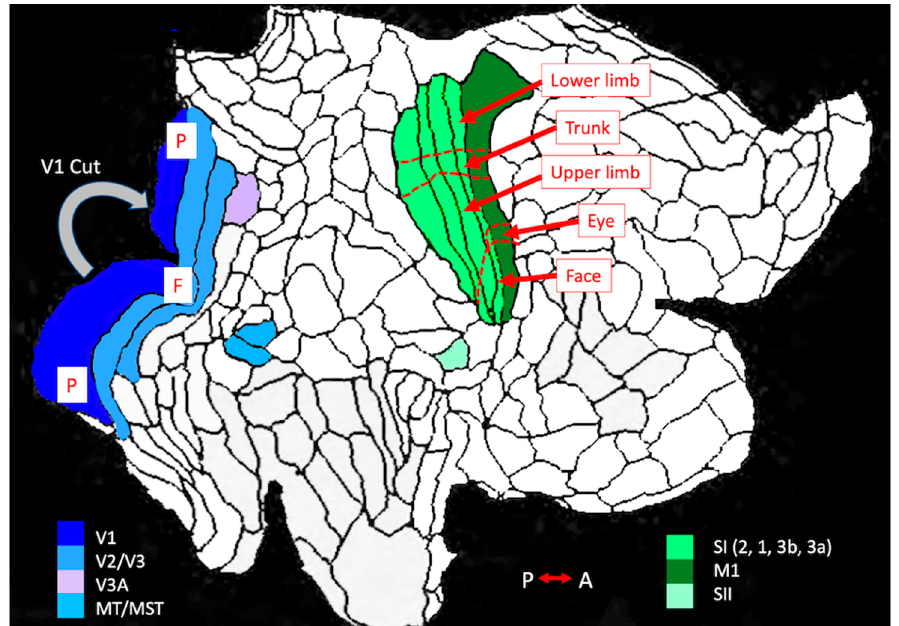
Figure 4. Flat map of human right hemisphere showing the parcellation of neocortex, adapted by permission from Springer Nature: A multi-modal parcellation of human cerebral cortex, Supple- mentary neuroanatomical results (Supplementary Figures 1 and 8), M.F.Glasser et al. Copyright 2016. Primary visual cortex (V1) in dark blue, with cut indicated. Secondary visual cortical areas V2 and V3 in light blue. The location of foveal (F) and peripheral (P) representations are indicated. Higher level occipital visual areas V3a (mauve) and MT/MST (turquoise). Primary somatosensory cortex SI, in medium green, consisting of BA3a, BA3b, BA1 and BA2 moving from anterior to posterior (A-P). Adjacent to BA3a is motor cortex (BA4) in dark green. The small light green area be- low and posterior to SI is SII, a secondary somatosensory area. The axis perpendicular to the A-P comprises shifts in both medial-lateral and superior-inferior directions in the three-dimensional brain. For simplicity in the text, the end of the somatosensory areas representing the hindlimb is designated as Top/Upper, and the face region as Bottom/Lower. Functional subdivisions of soma- tosensory and motor cortex are indicated, as described and illustrated by Glasser et al. [38; Supple- mentary neuroanatomical results Figure 8].